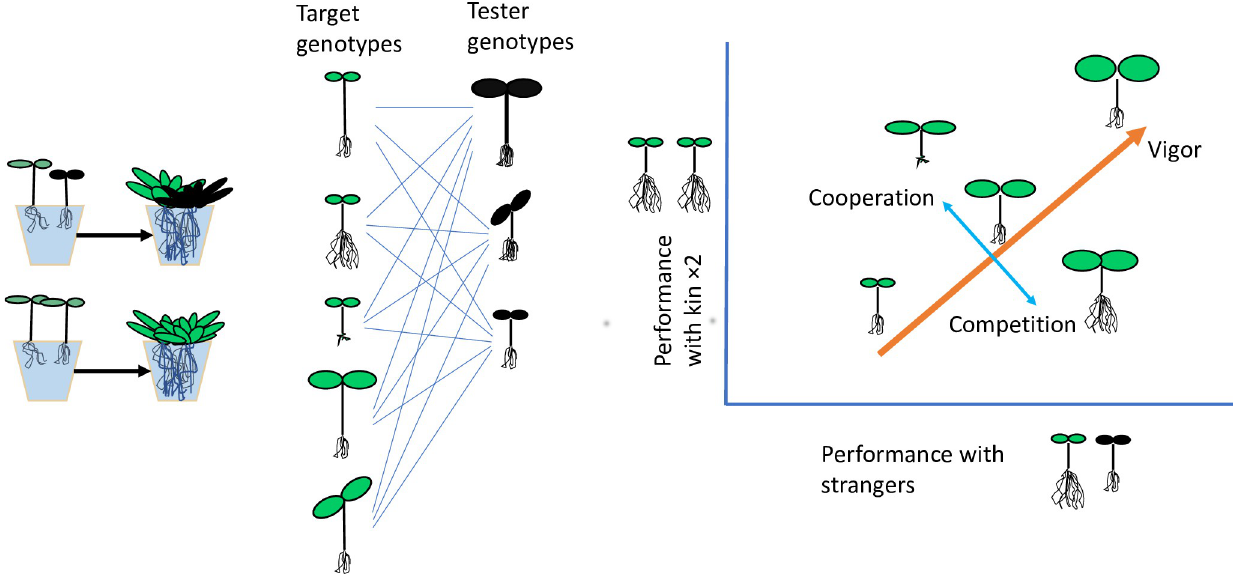
Fig 1. Screening for cooperative and competitive genotypes in Wuest and colleagues [4]. Seedlings vary in putative competitive traits: leaf size as a measure of plant size, stem elongation and leaf orientation as aboveground competitive traits, and root allocation as a belowground competitive trait. (A) The focal Arabidopsis genotypes (green) were paired with either kin, e.g., same genotype, or a stranger from the test genotypes (black), grown until mature, and the focal plant aboveground biomass harvested for performance. (B) Since all 98 focal genotypes were grown with each of 10 tester genotypes, the average genotype performance with a stranger also provides a relative measure of competitive ability [10]. (C) Each point is a focal genotype, with the average performance of 2 kin seedlings plotted against the average performance of a single seedling grown with tester genotypes. Genotypes with large seedling leaves grow into larger plants whether their competitor is kin or stranger, i.e., they vary in vigor (orange, thick line). Genotypes with similar vigor may perform with kin or with strangers, i.e., they vary in cooperation relative to competition (cyan, thin line). Here, the cooperation-competition associated variation, corresponding to the G-I axis in Fig 1 of Wuest and colleagues [4], is associated with root allocation. More cooperative genotypes have less root allocation, while genotypes with greater root allocation outcompete their neighbors.